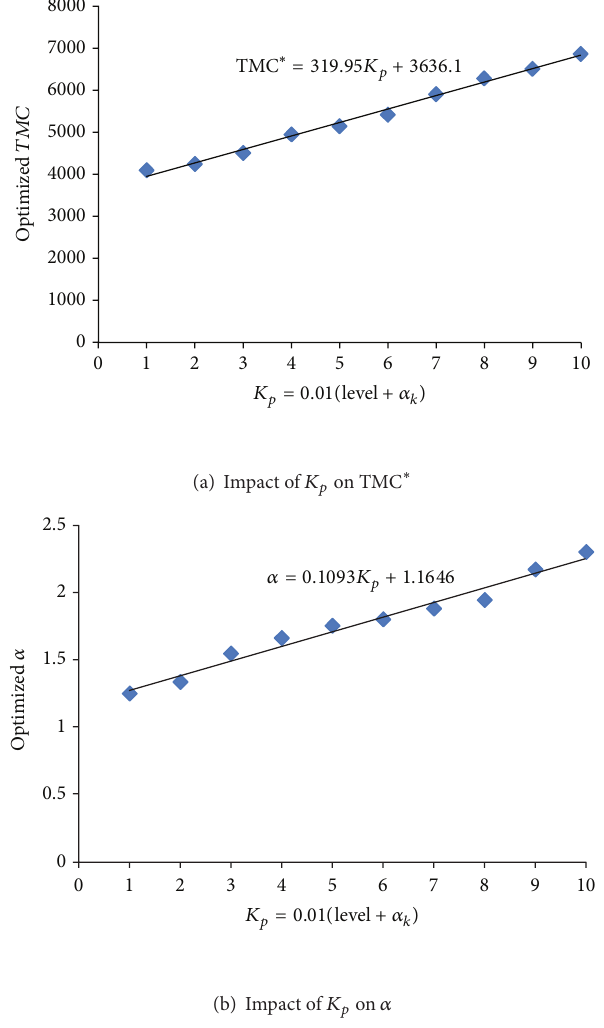
Figure 5: Sensitivity analysis based on 𝐾 𝑝